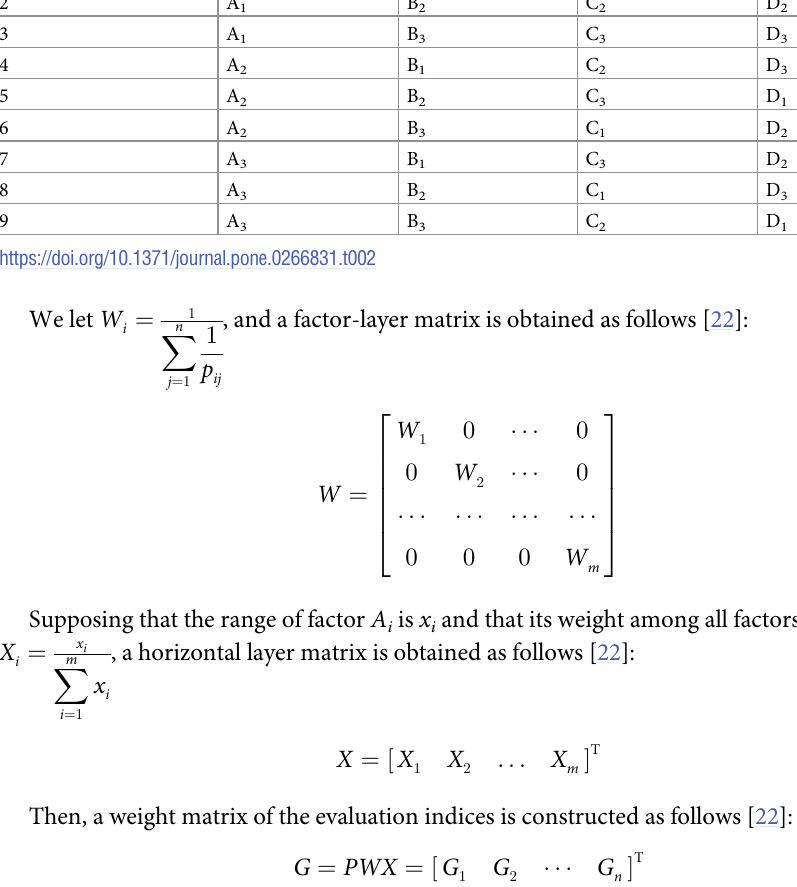
Table 2. Orthogonal test table. Test no. Factor